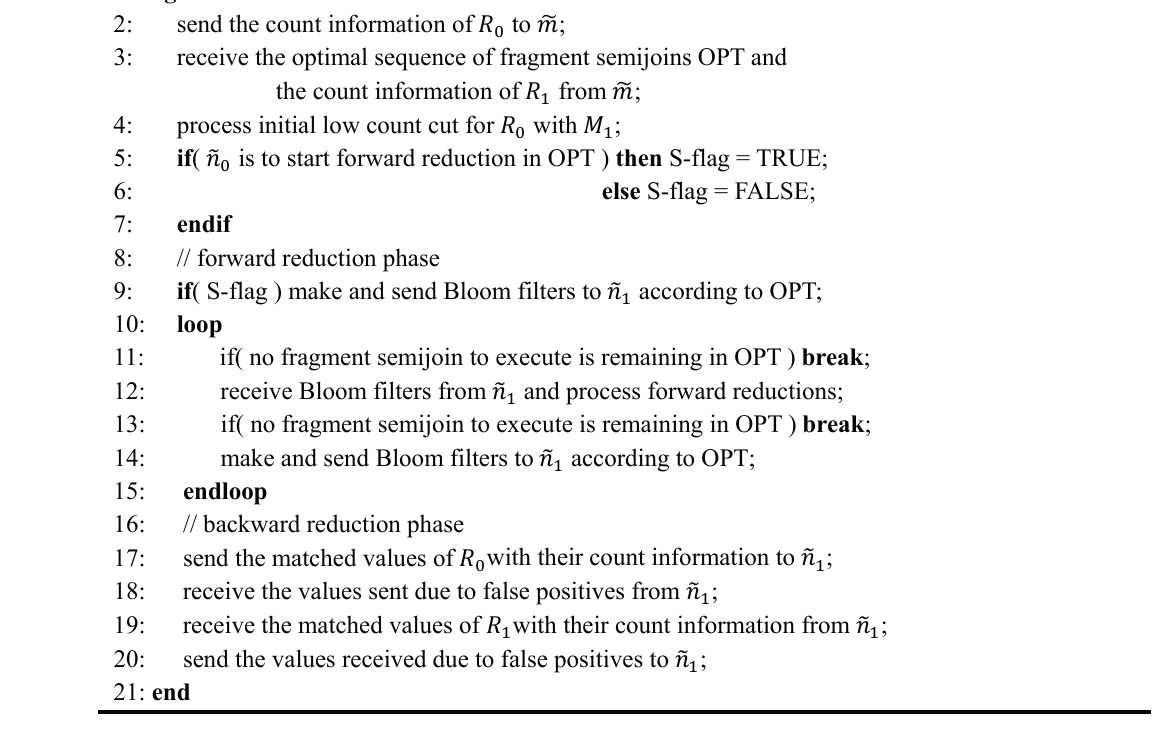
Figure 10. Protocol Executed by (cid:2196)(cid:3557)